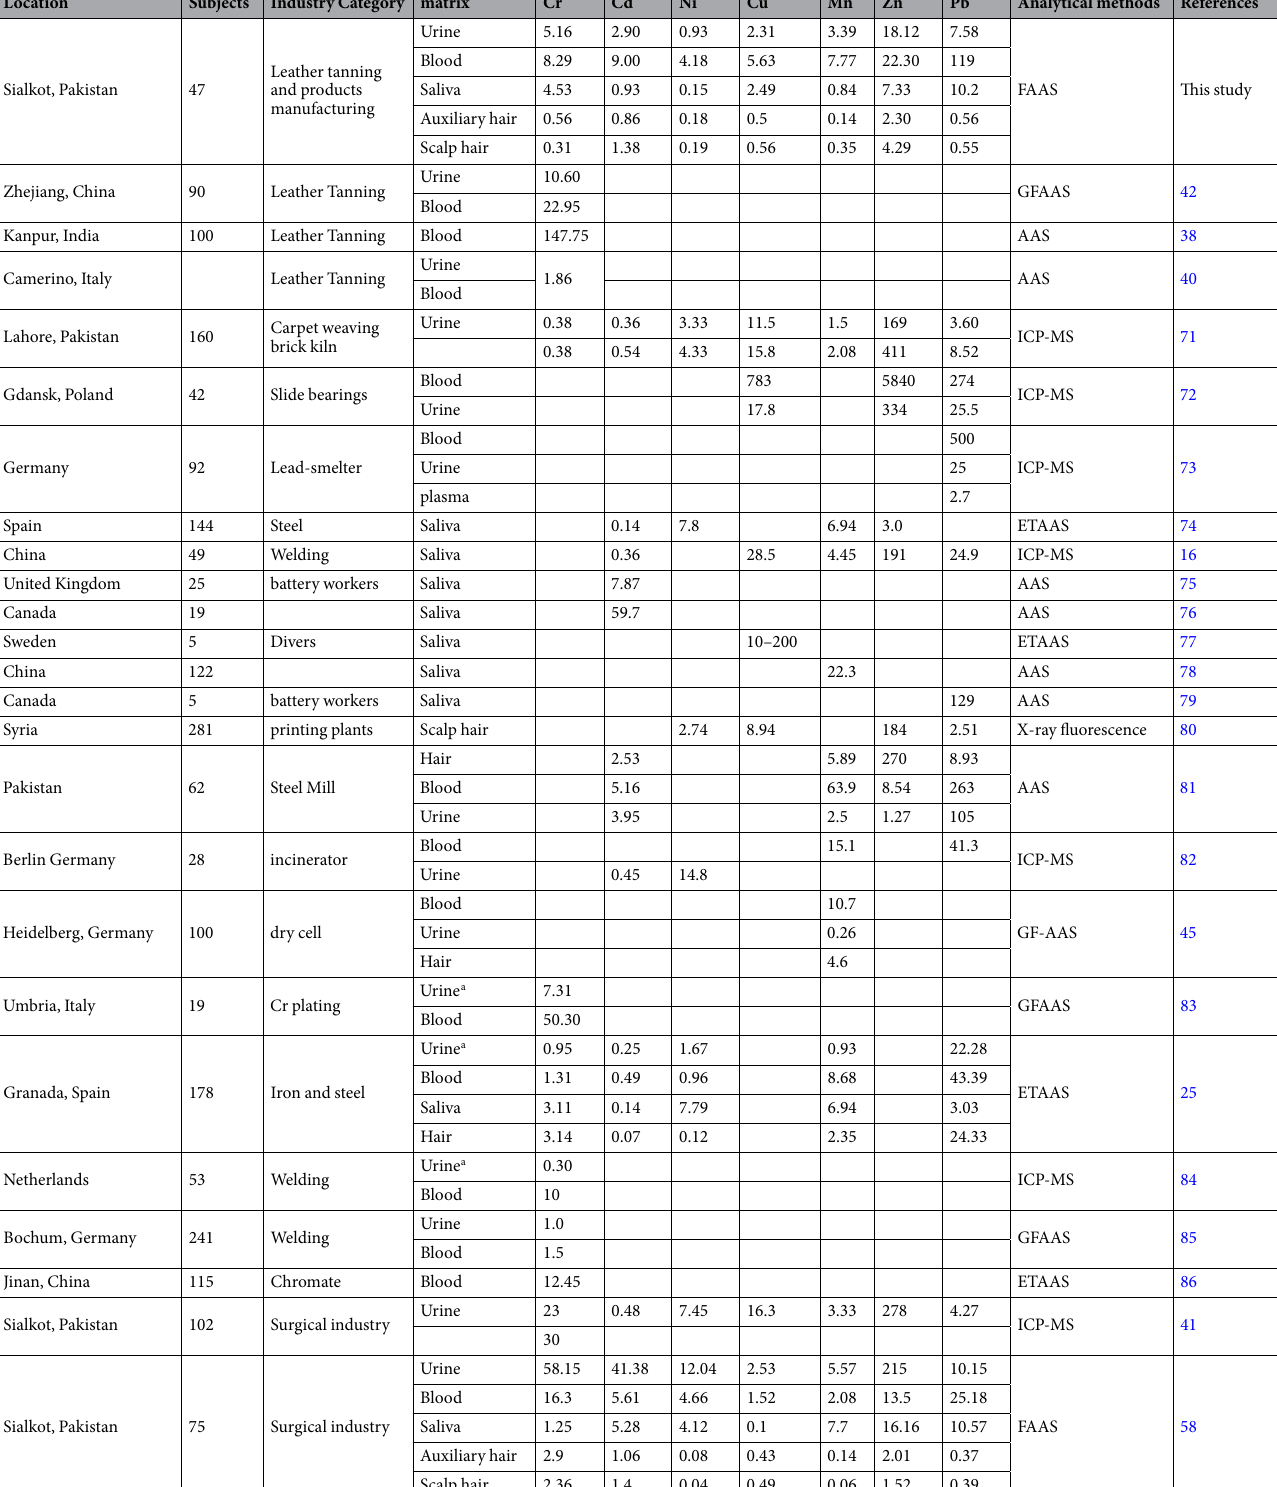
Table 2. Concentration level of heavy metals in the biological matrices of workers in different occupational settings from published literature. Units: urine ( µ g/L, a µ g/g creatinine), blood & saliva ( µ g/L), hair ( µ